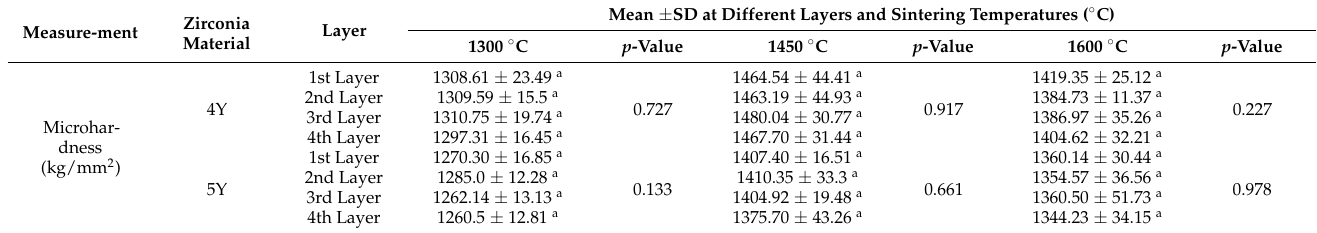
Table 4. Results of one-way ANOVA comparing the mean Vickers microhardness of zirconia layers within the same material and sintering temperature followed by multiple comparison test (Dunnett